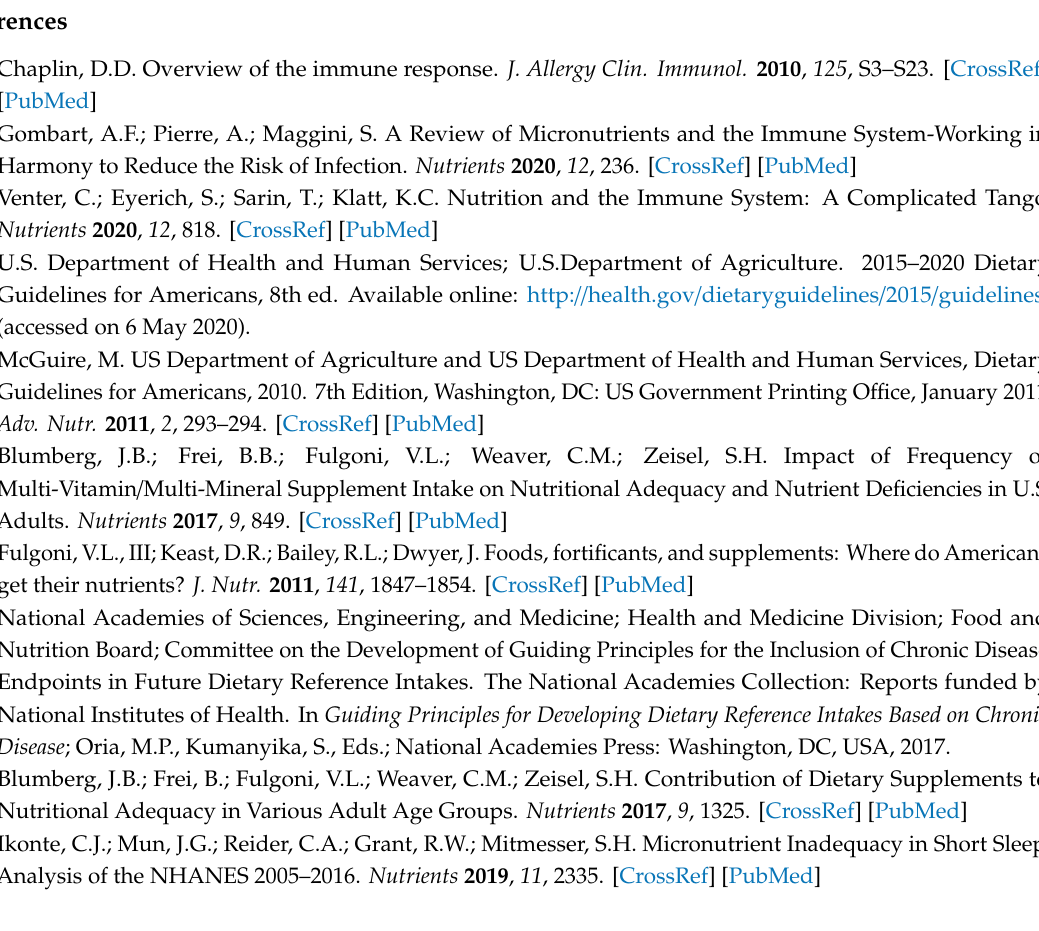
Table S1: Micronutrient usual Intake (UI), prevalence of inadequacy (% of population below EAR) and % of population exceeding the UL from food only and food + supplements in all adults ( > 19